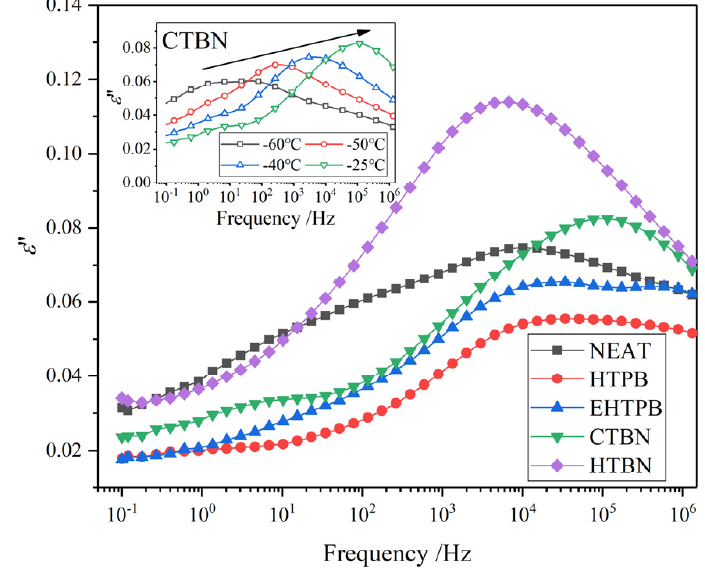
Figure 9. Spectrum curves of epoxy resins toughened by a different rubber at − 25 °C. The inset picture is the frequency spectrum of low temperatures of sample with 15% CTBN, which shows the variety of the interfacial polarization. The relaxation process on pure epoxy resin curve is the secondary transition relaxation process of epoxy resin. The relaxation process on the remaining curves is mainly caused by the α transition of rubber molecules.